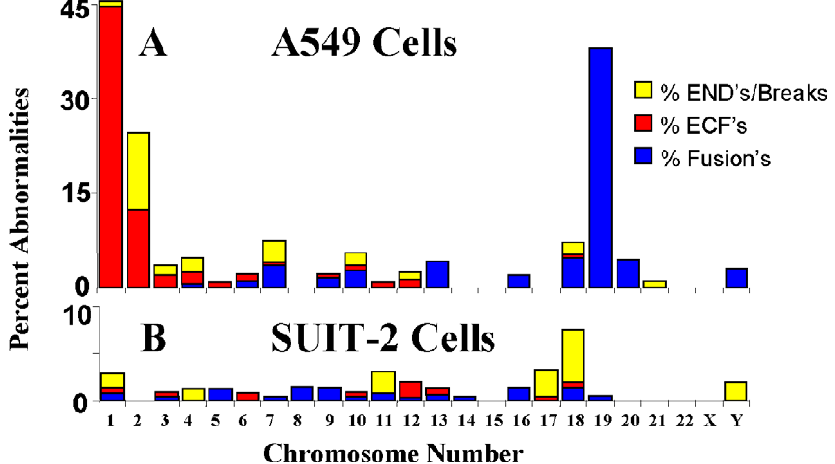
Fig. 2. The average percentages of FISH-identified chromosome abnormalities per individual chromosome in the (A) A549 and (B) SUIT-2 lines. (Reproduced, with permission from Isaka, T., Nestor, A.L., Takada, T. and Allison, D.C. Chromosomal variations within aneuploid cancer lines. J Histochem Cytochem , 51 , 1343–53,